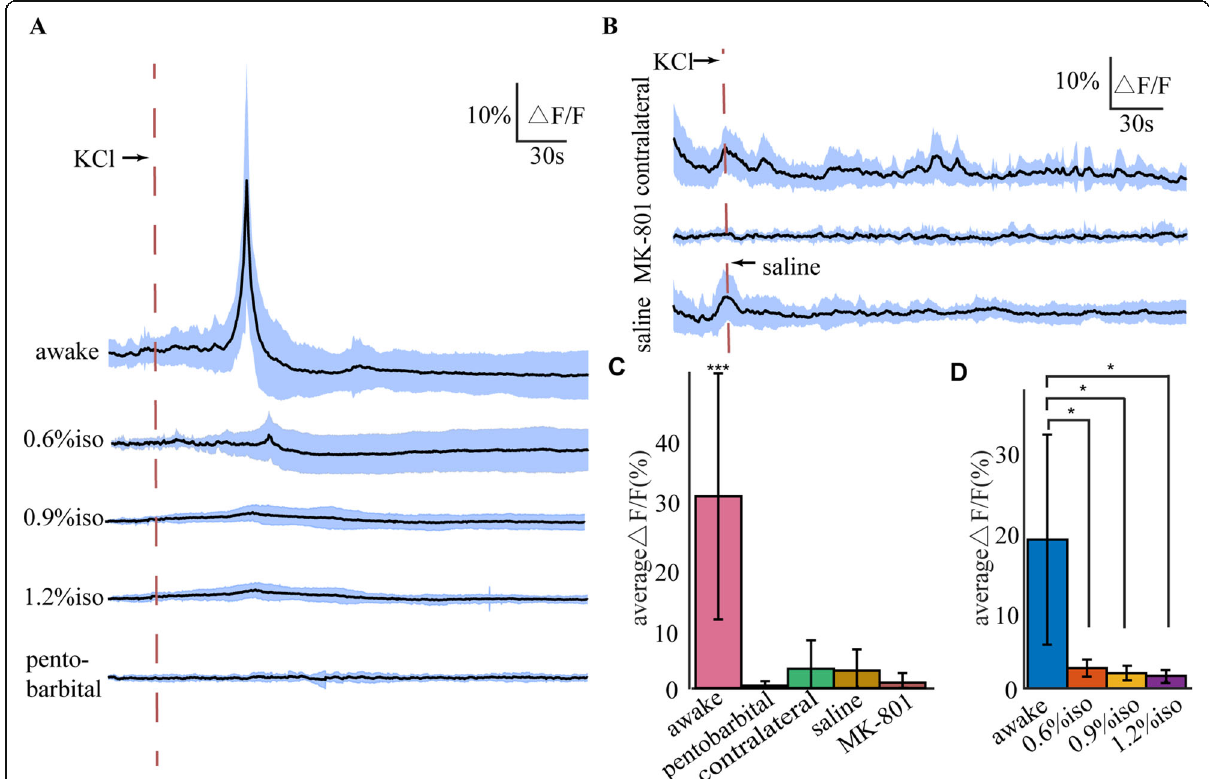
Fig. 4 Statistics of KCl-induced responses in the VPM under different conditions. A KCl application activated VGluT2 neurons in the ipsilateral VPM in awake mice ( n = 50). When anaesthetized with isoflurane (0.6%, 0.9%, 1.2%, n = 10 respectively), or 50 mg/kg pentobarbital ( n = 13), CSD did not significantly activate VGluT2 neurons in the VPM. Data are presented as means ± SD. B KCl application did not activate VGluT2 neurons in contralateral VPM ( n = 15), or when the cortex was topical affected by NMDA receptor antagonist MK-801 ( n = 8). When saline was applied ipsilaterally instead of KCl ( n = 16), there was no significant activation. Data are presented as means ± SD. C The maximum average relative fluorescence change under different conditions. Data are presented as means ± SD. *** P <0.001 based on ANOVA between stimulated state and resting state in each case. D The maximum average relative fluorescence changes of 10 experimental mice under isoflurane anesthetized or awake state. Data are presented as means ± SD. * P <0.05 based on repeated measures ANOVA between awake state and 3 different levels of isoflurane anesthetized state. When anaesthetized with isoflurane, the activation of VGluT2 neurons in the VPM by CSD application was significantly decreased ( P